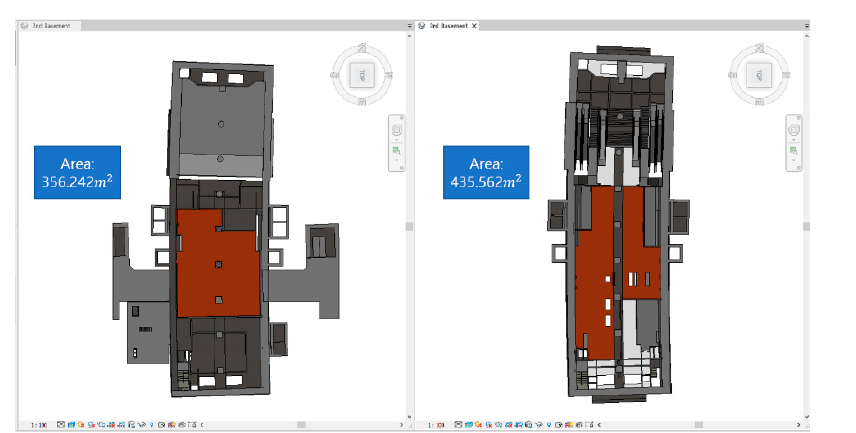
Figure 4. Evacuation path.